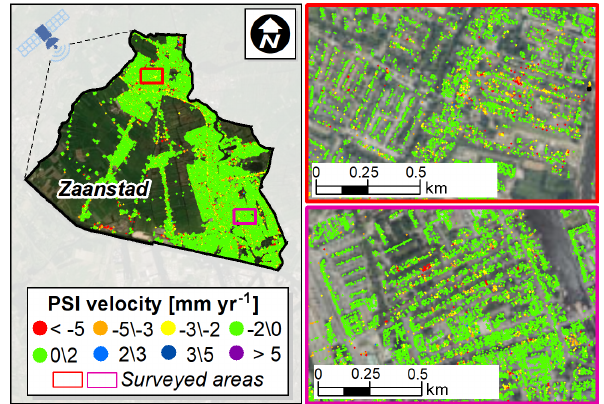
Figure 3. PSI velocity distribution on ascending orbit provided by the TSX radar sensor in the period 2009–2018. Source: Image from © Google